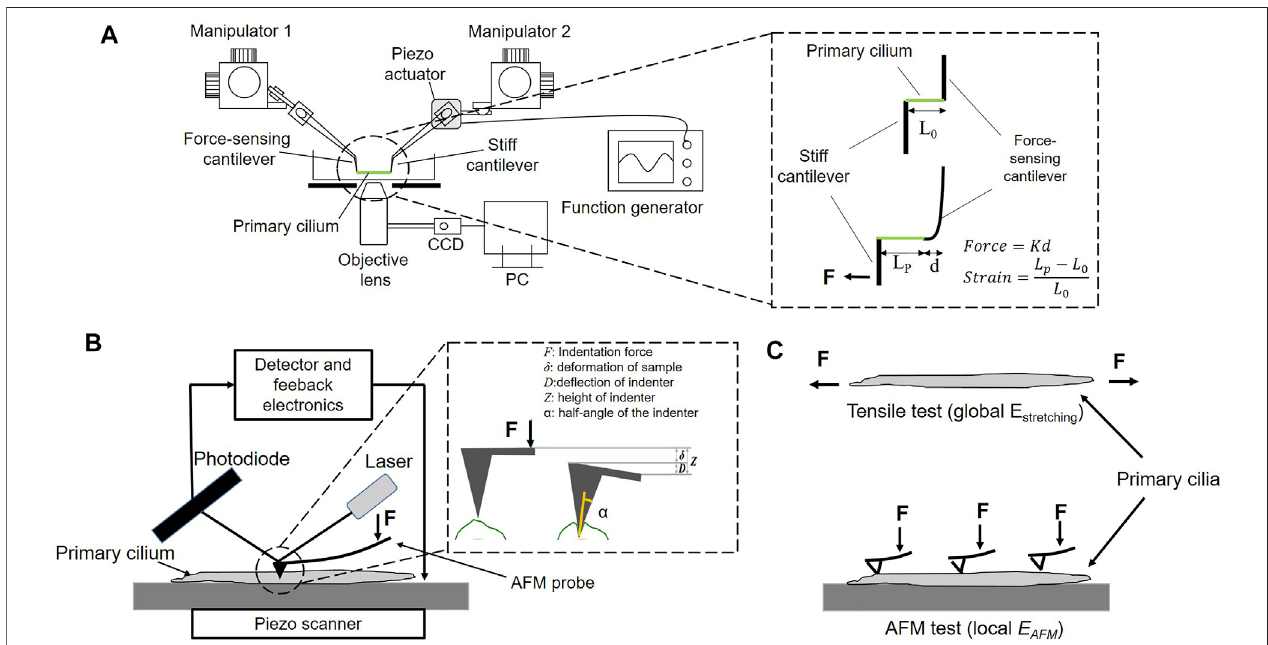
FIGURE 1 | (A) Experimental setup of the micro-tensile test. K : the spring constant, d : the displacement of the force-sensing cantilever, L 0 and L p : the length of a primary cilium before and after stretching, respectively (B) Experimental setup of the AFM test (C) The global Young ’ s modulus E stretching and the local Young ’ smodulus E AFM of a primary